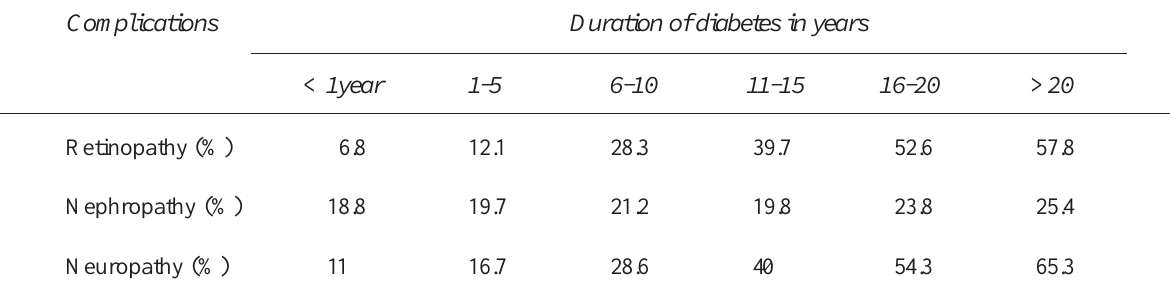
Table 1. Prevalence of complications of diabetes